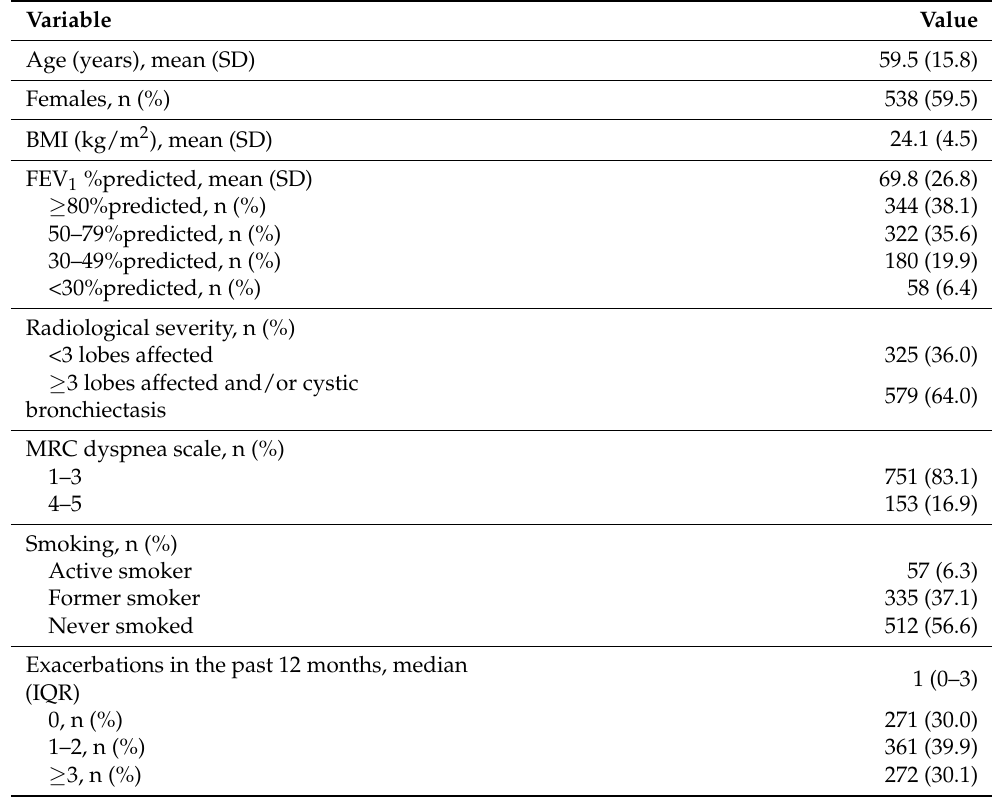
Table 1. Demographic and baseline characteristics ( n =